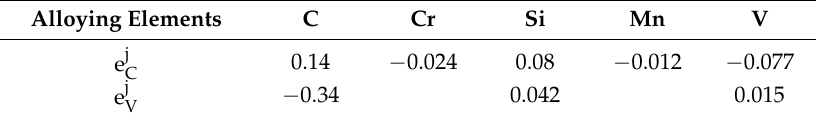
Table 4. The interaction coefficient of alloying elements in molten iron at 1600 ◦